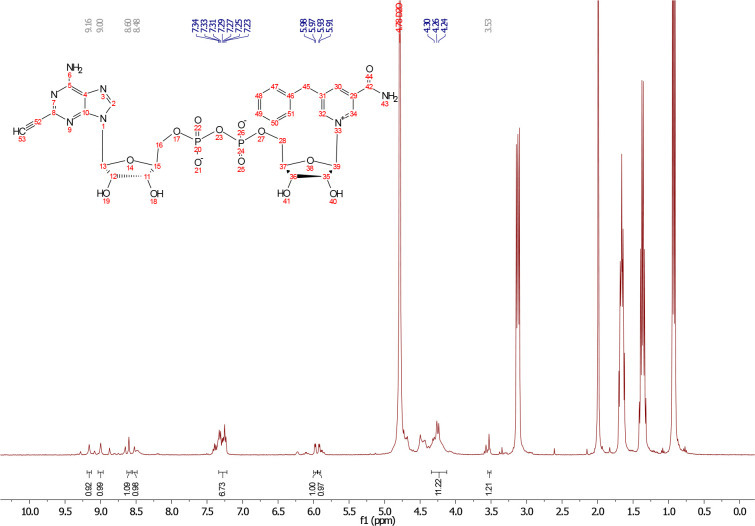
1H NMR of compound 6 (5-benzyl-2-ethynyl-NAD+).